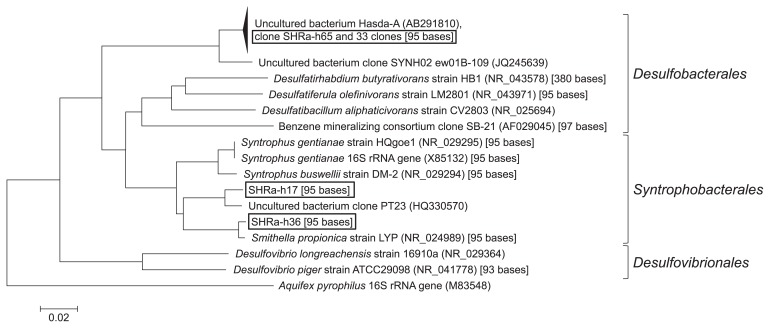
Phylogenetic tree of the bacterial 16S ribosomal RNA (rRNA) gene clones belonging to T-RF1 in the 1.729 g cm−3 fraction of the labeled treatment on day 64. Boxed clones are those collected in this study. The number in the parentheses indicates the accession number of the reference sequence. The number in the brackets indicates the T-RF length obtained by in silico analysis.